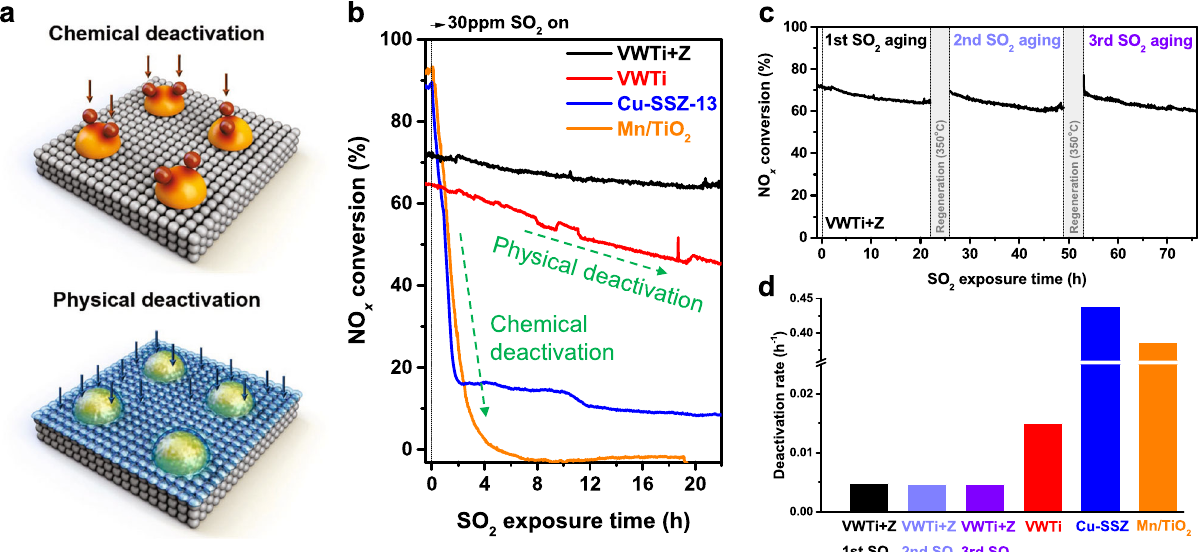
Fig. 1 Stable and reusable NO x removal system during NH 3 -SCR reaction with SO 2 . a Schematic of two types of deactivation by sulfur species. b Comparison of SO 2 resistance of VWTi + Z catalyst to VWTi and common low temperature catalysts (Cu-SSZ-13 and Mn/TiO 2 ). The catalysts were aged under 500 ppm NO, 600 ppm NH 3 , 10% O 2 , 5% CO 2 , 10% H 2 O, and 30 ppm SO 2 balanced with N 2 . c Regeneration and reusability test of the VWTi + Z system until the third operation. Regeneration gas contains 10% O 2 , 5% CO 2 , and 10% H 2 O balanced with N 2 . d Deactivation rate of the catalysts during SO 2 aging. Deactivation rates of the VWTi and VWTi + Z were obtained by linear fi ts of 22 h aging pro fi les and those of the Cu-SSZ-13 and Mn/TiO 2 were calculated from initial 2 h aging